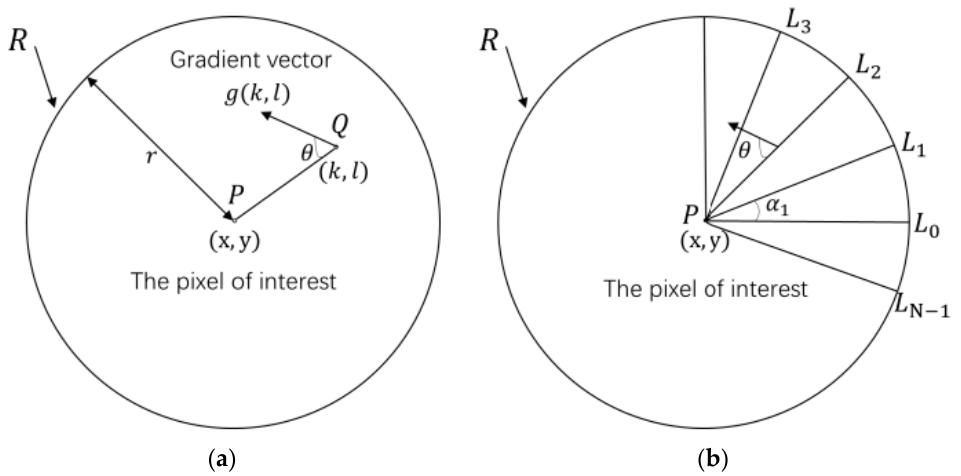
Figure 4. The convergence index (CI) filter. ( a ) Support region and the angle θ ( k , l ) . ( b ) Union of N half-lines.